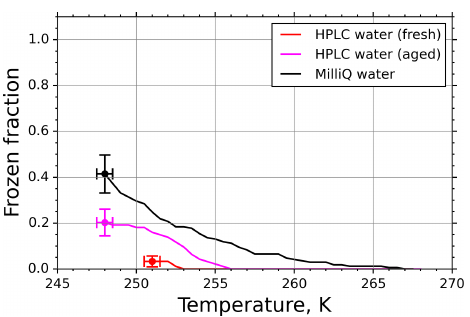
Figure 8. Freezing spectra of water of different purity grades: high- precision liquid chromatography water (HPLC; Sigma-Aldrich) and in-house-purified Milli-Q